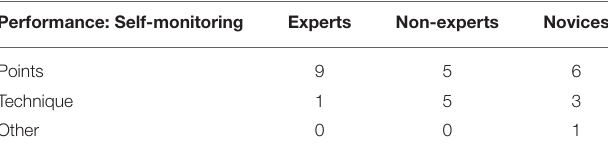
TABLE 6 | An overview of how different self-monitoring techniques were used across the three skill levels.